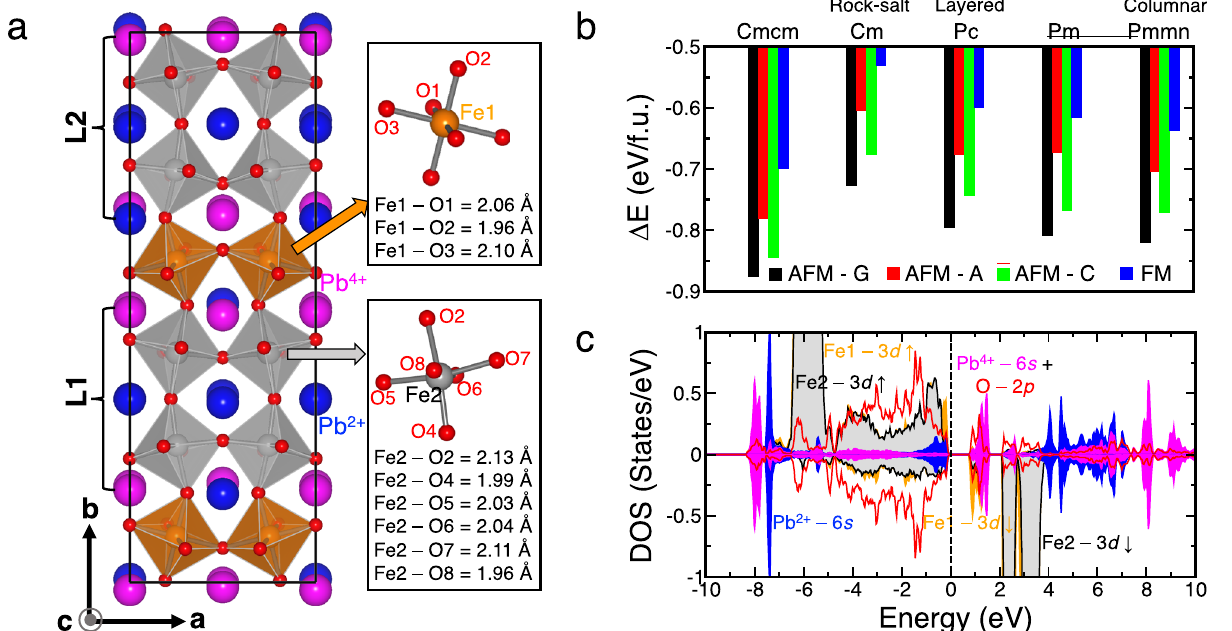
Fig. 4 Charger-ordered phase description and electronic structure analysis. a Description of Pb 2 + /Pb 4 + -ordered optimized Cmcm structure. b Calculated energies of various Pb 2 + /Pb 4 + -ordered structures considering four collinear arrangements between Fe spins. Relative energy ( Δ E ) is shown with respect to undistorted ferromagnetic phase. c Calculated density of states of lowest energy charge-ordered Cmcm structure in G -type antiferromagnetic